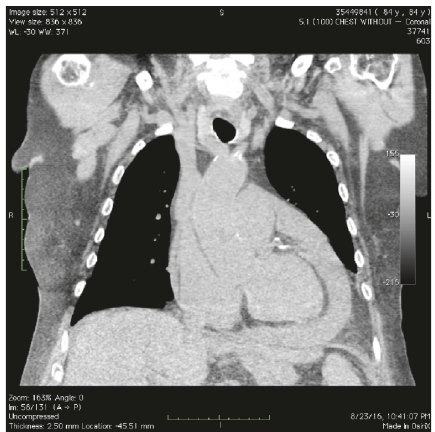
Figure 2: Computerized tomography (CT) of the chest showing new pericardial effusion and small bilateral pleural effusions with adjacentatelectasiswhencomparedtotheCTofthechestperformed 21 days